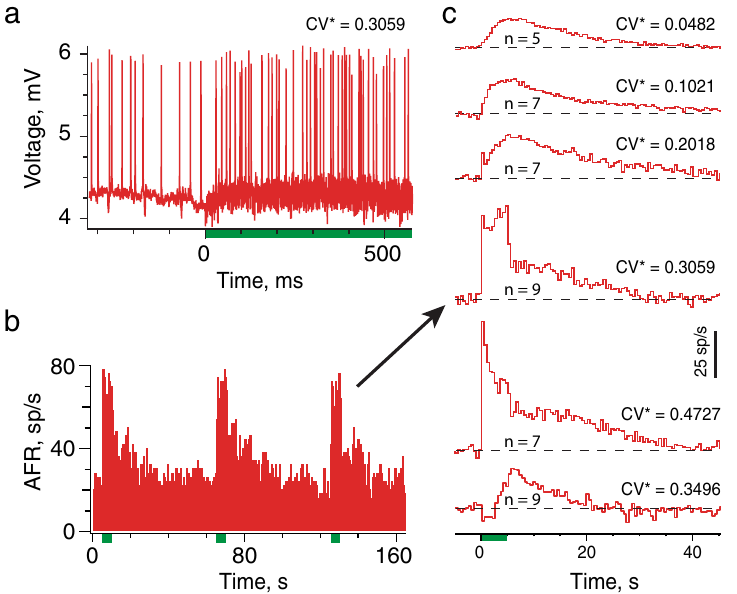
Figure 3. Ipsilateral efferent stimulation elicits fast and slow excitation. ( a ) Irregularly-discharging afferent showing the onset of ipsilateral brainstem stimulation (333 shocks/s, green bar). ( b ) Corresponding continuous histogram showing changes in afferent firing rates during three successive ipsilateral stimulation trials (333/s for 5 s delivered every 60 s, green boxes). Average response histogram shown to the right of arrow. ( c ) Average response histograms to ipsilateral efferent stimulation (background subtracted) in five units with different CV* values. Histograms are plotted as a displacement from background (dashed line). Number of trials used to construct mean histograms indicated in each trace. Binning in panels ( b,c) is 500